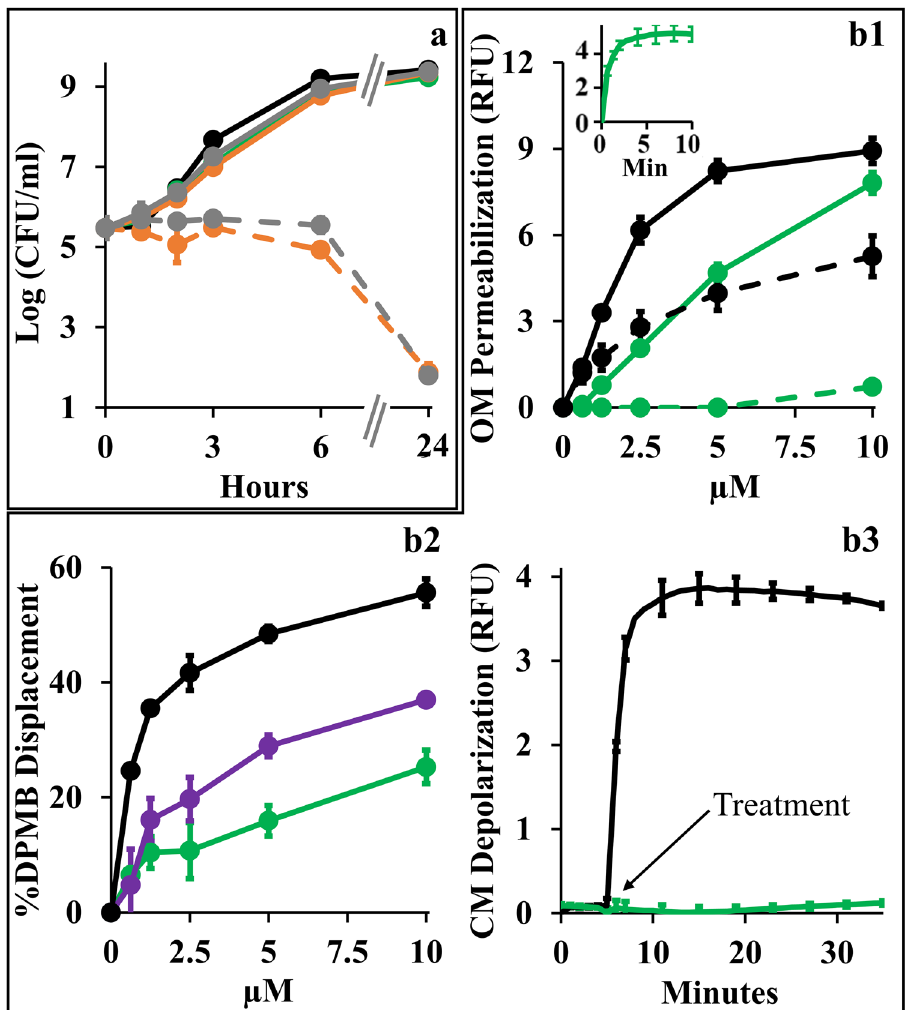
Figure 4. Mechanistic Studies of C 10 BBc 12 B Using E. coli 25922. ( a ) Growth kinetics in presence of single versus combined antimicrobials. Untreated control, black; 10 µM C 10 BBc 12 B, green; 1 µg/ml erythromycin, solid gray; 20 ng/ml rifampin, solid orange; 1 µg/ml erythromycin with 10 µM C 10 BBc 12 B, dashed gray; 20 ng/ml rifampin with 10 µM C 10 BBc 12 B, dashed orange. ( b1 ) OM permeabilization assessed using NPN fluorescence measurements, in presence or absence of 10 mM MgCl 2 . PMB, solid black; C 10 BBc 12 B, solid green; PMB in presence of 10 mM MgCl 2 , dashed black; C 10 BBc 12 B in presence of 10 mM MgCl 2 , dashed green. Data represent fluorescence after 6 min. Inset shows representative fluorescent signal evolution kinetics for 10 µM C 10 BBc 12 B. ( b2 ) Percent displacement of mono-dansylated PMB from E. coli LPS. PMB, black; PMBN, purple; C 10 BBc 12 B, green. Data represents results from two independent experiments. ( b3 ) CM depolarization assessed using DiSC 3 (5) fluorescence measurements. 2.5 µM PMB, black; 10 µM C 10 BBc 12 B, green. Arrow denotes the moment of antimicrobials addition after DiSC 3 (5) baseline signal stabilization. RFU, relative fluorescence units. Error bars represent standard